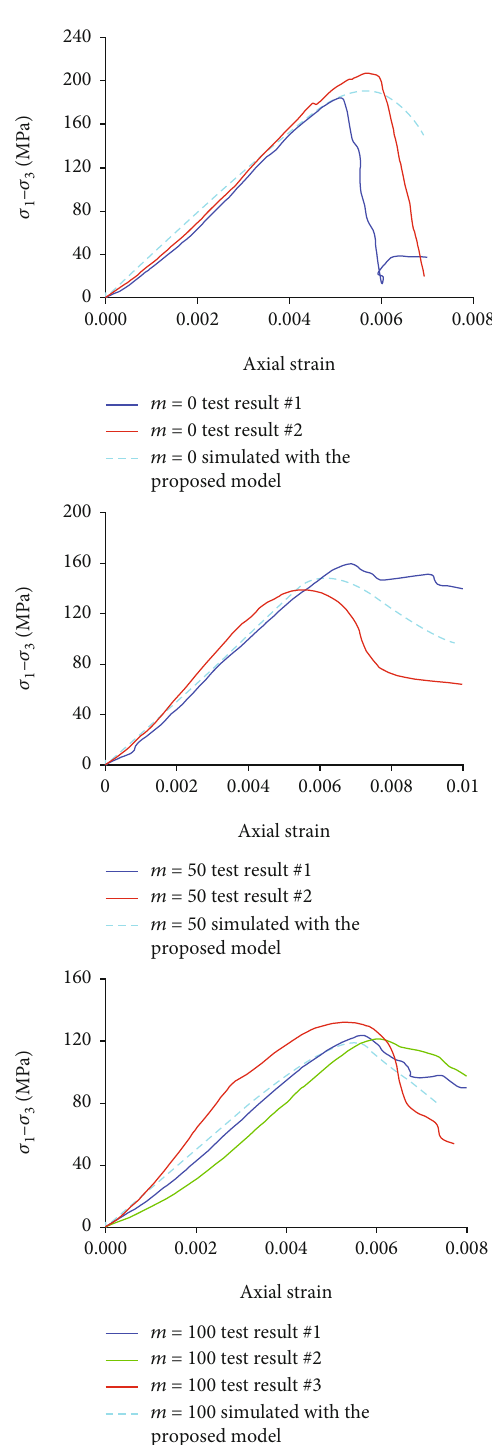
Figure 8: Comparison of the stress-strain relationships for triaxial compression tests with con fi ning pressure σ 3 = 5 MPa by Tan et al. [36] and simulated with the proposed model. The predicted stress- strain relationships agree well with the tested ones.